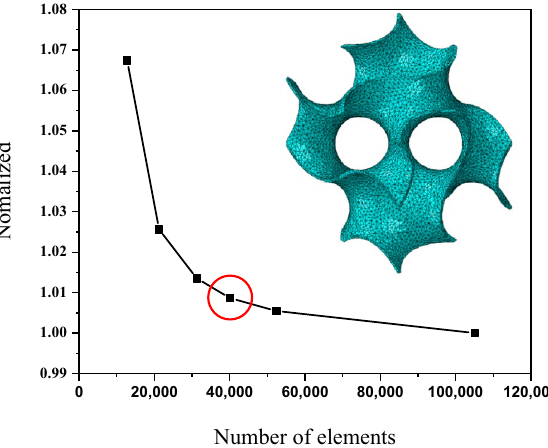
Figure 1. Mesh convergence study performed for gyroid structure. The result indicates the optimum mesh size for the single gyroid structure (40,216 elements) without sacrificing the computational